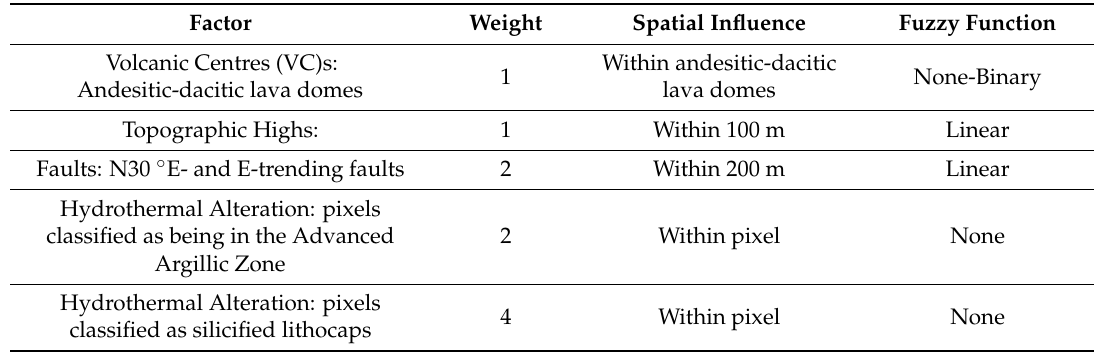
Table 3. Recognition criteria for intermediate-high sulphur epithermal deposits on the Island of Milos, with relative weightings and extent and nature of spatial influence. Spatial Influence Fuzzy